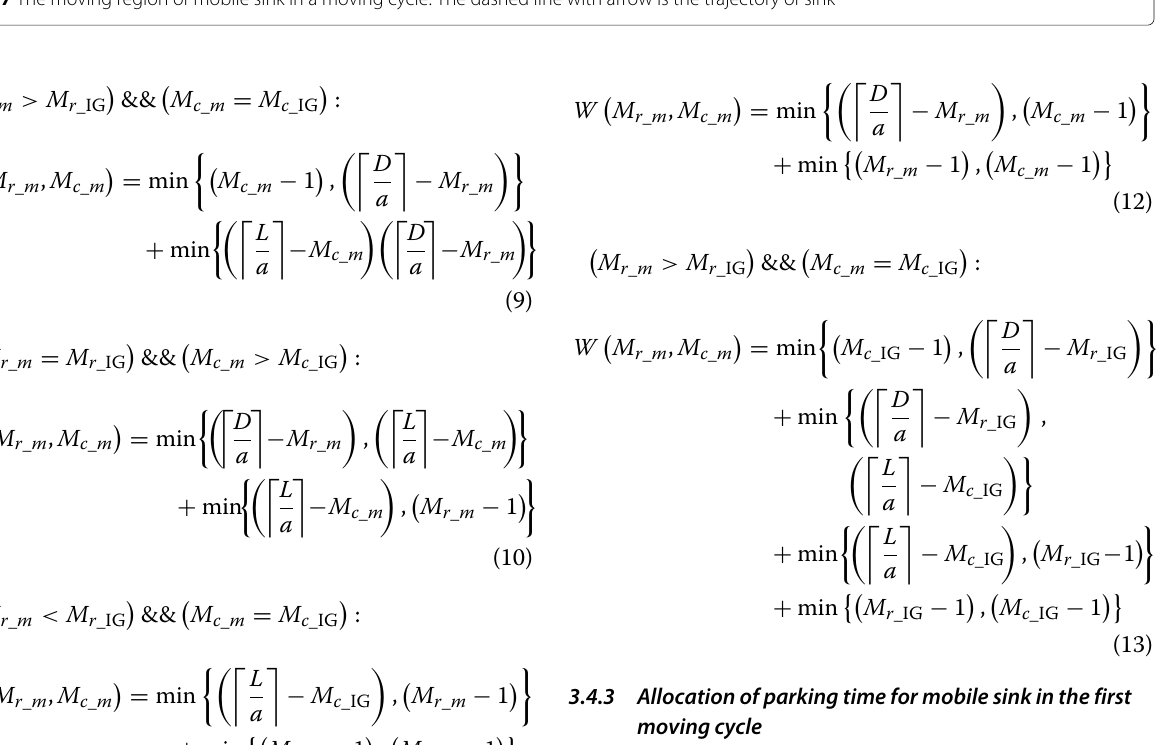
Fig. 7 The moving region of mobile sink in a moving cycle. The dashed line with arrow is the trajectory of